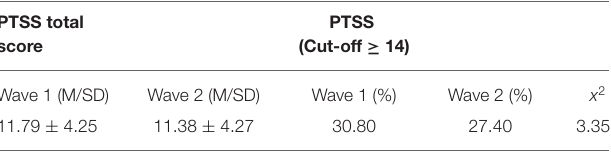
TABLE 2 | Prevalence and change of PTSS in Waves 1 and 2 (February 2020 and August